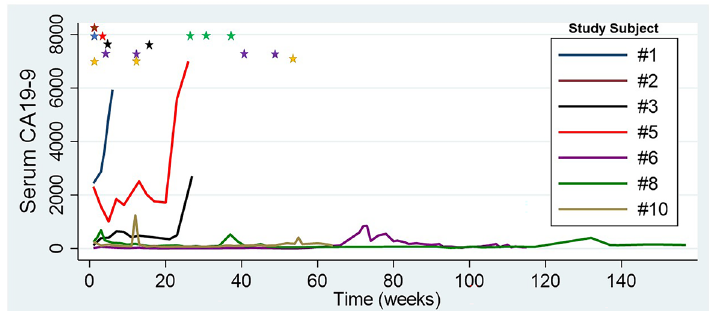
Figure 1. Trend of serum CA19-9 after RFA treatment. Colored star at top of graph represents timing of EUS- RFA treatment.